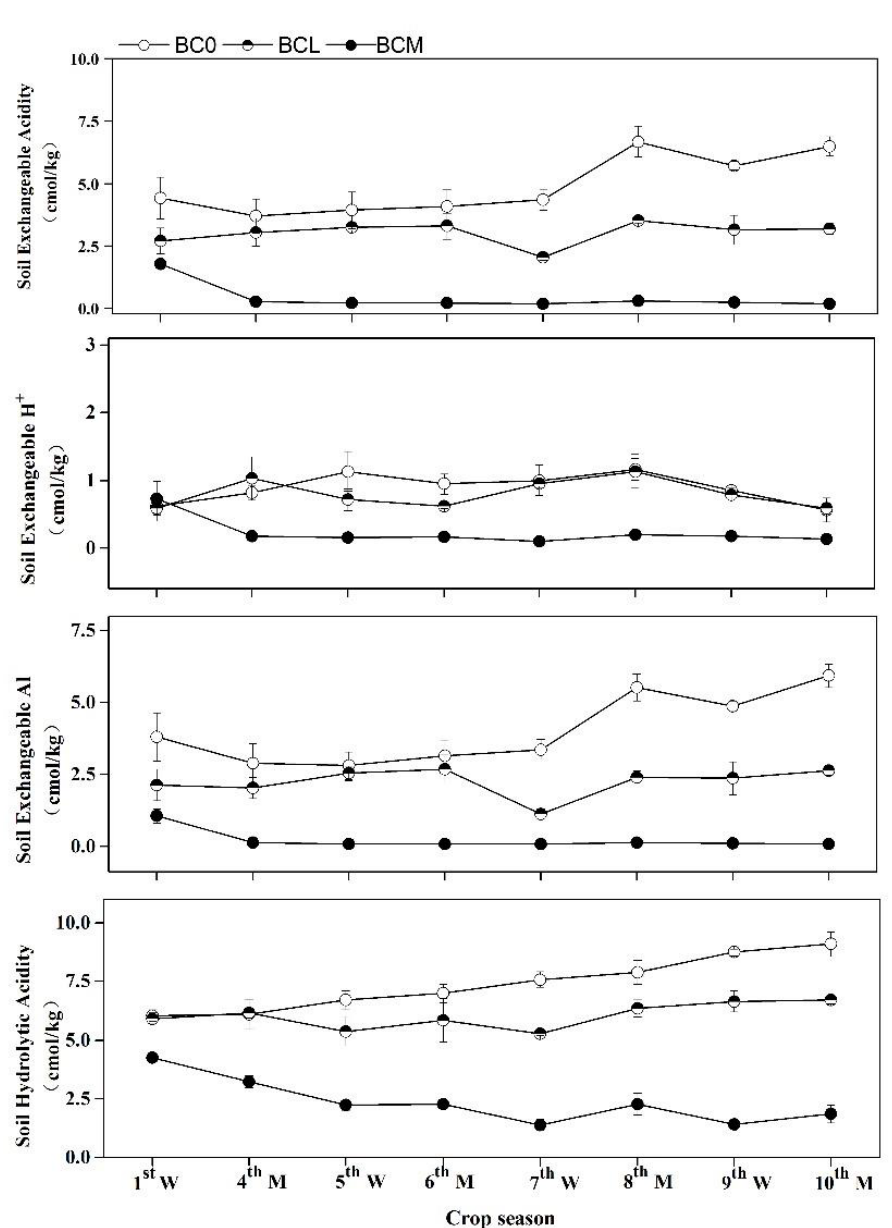
Figure 3. The change of soil exchangeable acidity (EA), exchangeable H + (EH), exchangeable Al 3+ , and hydrolytic acid (HA) in the red soil affected by successive applications of straw biochar during 10 consecutive wheat/millet growing seasons from 2010–2015. Soil exchangeable acidity (EA) and hydrolytic acid (HA) were not measured in the 2011 millet and 2011–2012 wheat seasons, respectively. Error bars are standard deviations.